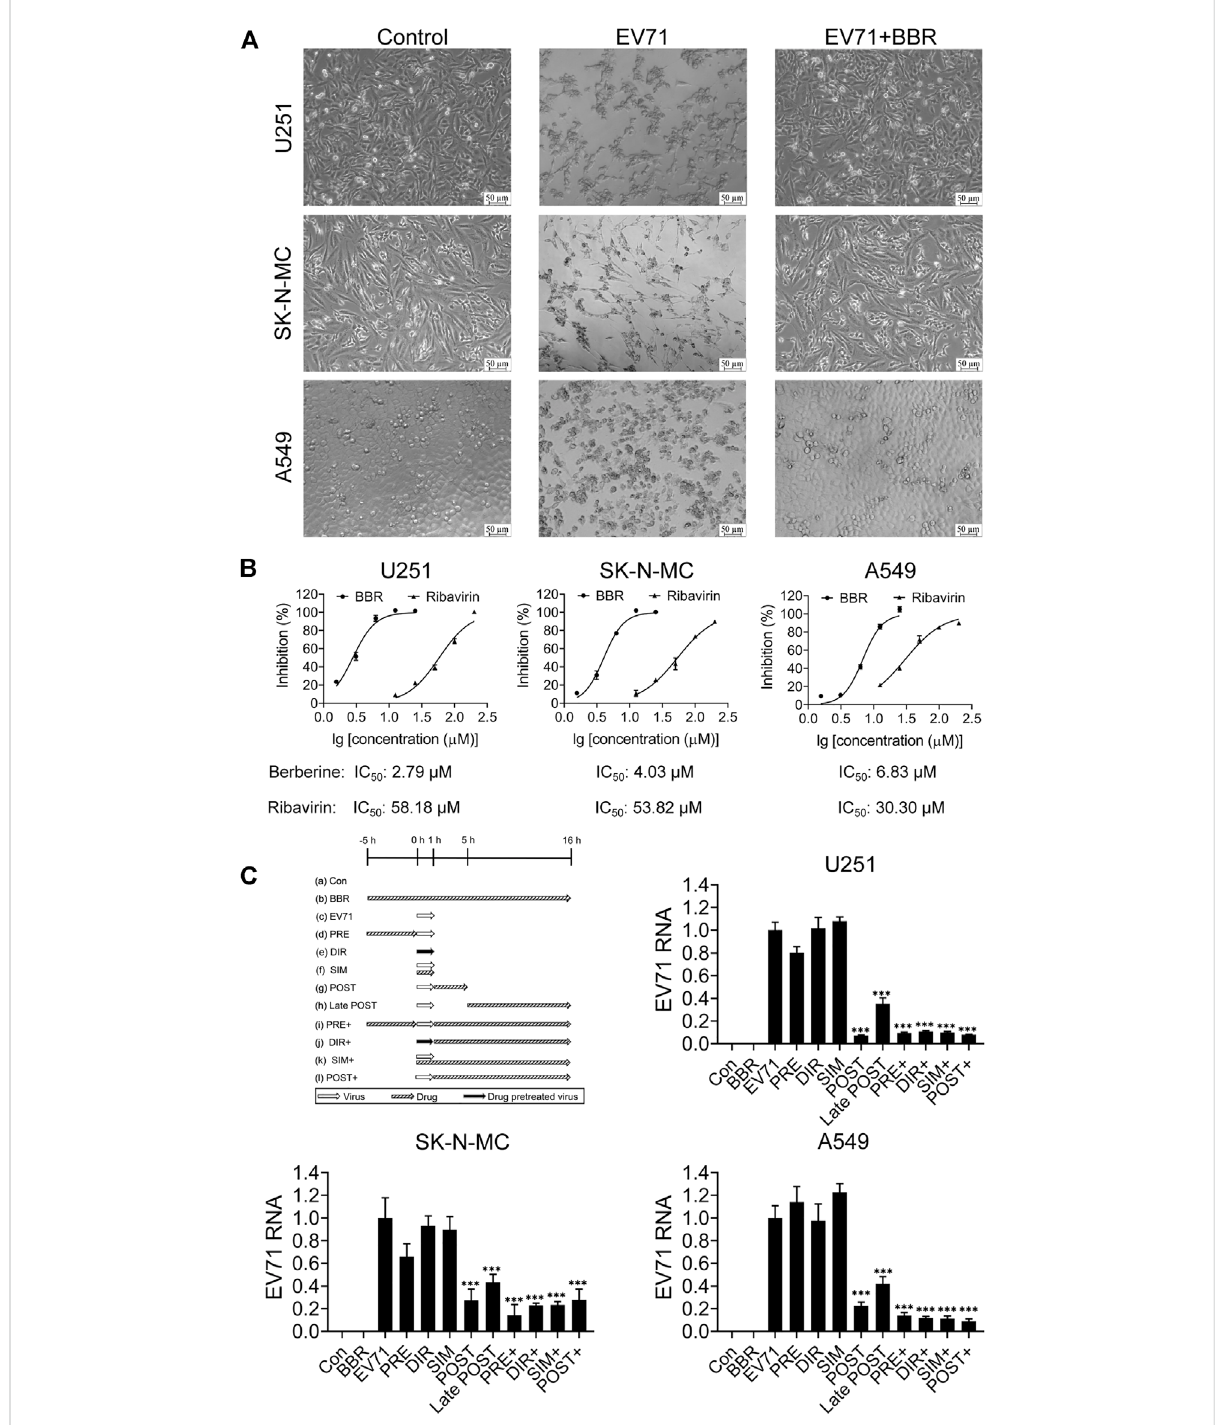
Antiviral activities of BBR against EV71. (A) Morphological changes of U251, SK-N-MC, and A549 cells at 72 h post EV71 infection w/o BBR treatment in the CPE inhibition assay. Bar = 50 μ m. (B) Dose-dependent anti-EV71 activities of BBR and ribavirin in different cell lines. (C) Effects of BBR on EV71 replication in the time of compound addition assay in different cell types. BBR concentrations at 5 μ M (U251) or 10 μ M (SK-N-MC and A549) were used ( n = 6). Data are presented as SD. Statistical signi fi cance was compared between the test groups and the EV71 group was represented by asterisks marked correspondingly in the fi gures, *** p < 0.001 vs. EV71